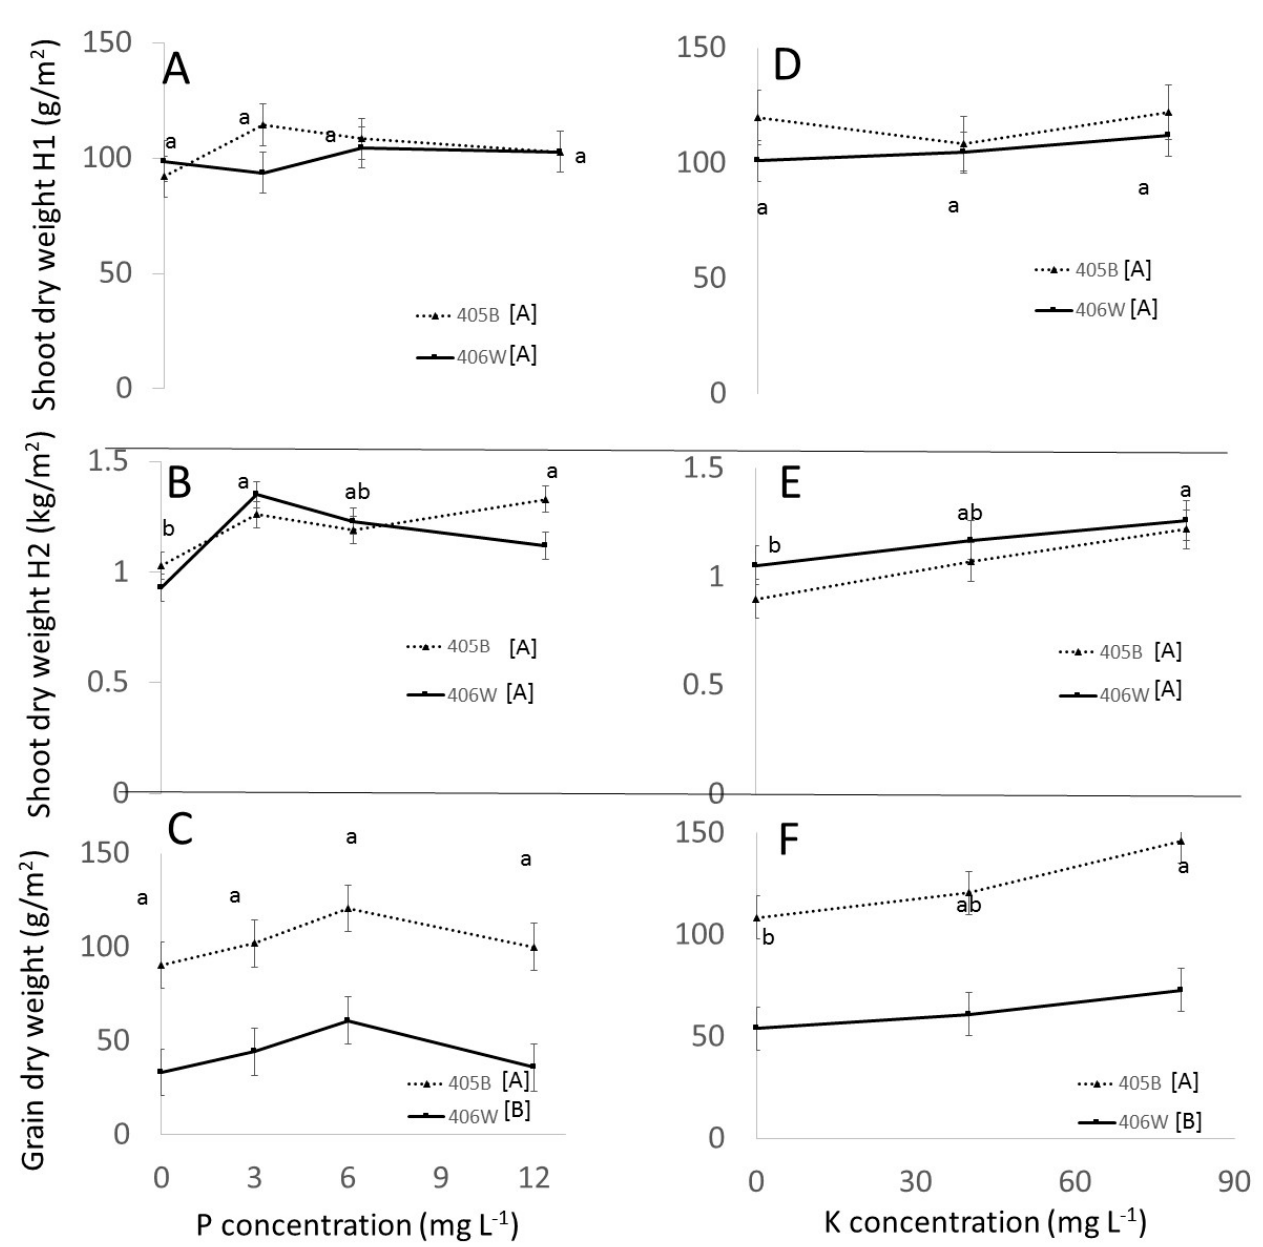
Figure 3. Shoot dry matter at flowering ( A ), Shoot dry matter at maturity ( B ) and grain dry matter ( C ) in the summer field experiment by P fertigation level, and Shoot ( D ), root ( E ) and grain ( F ) dry matter in the summer field experiment by K fertigation level. Dashed line represents 405B genotype, and solid line represents 406W genotype. Different letters represent significant (<0.05) differences for main effects. Lower case letters adjacent to the trend line represent the results of the Tukey test for N concentration averaged across genotypes, and capital letters adjacent to the legend represent the results of the Student- t test for the two different genotypes.